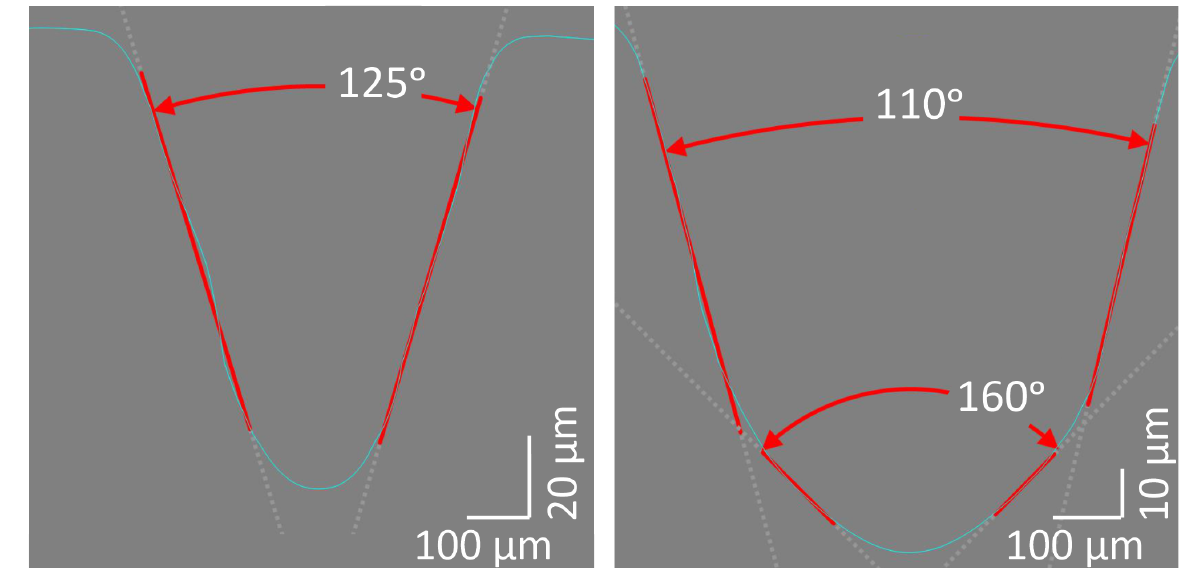
Figure 12. Focal length effect: P = 30 W, S = 140 mm/s; ( left ): F = 38.1 mm; ( right ): F = 127